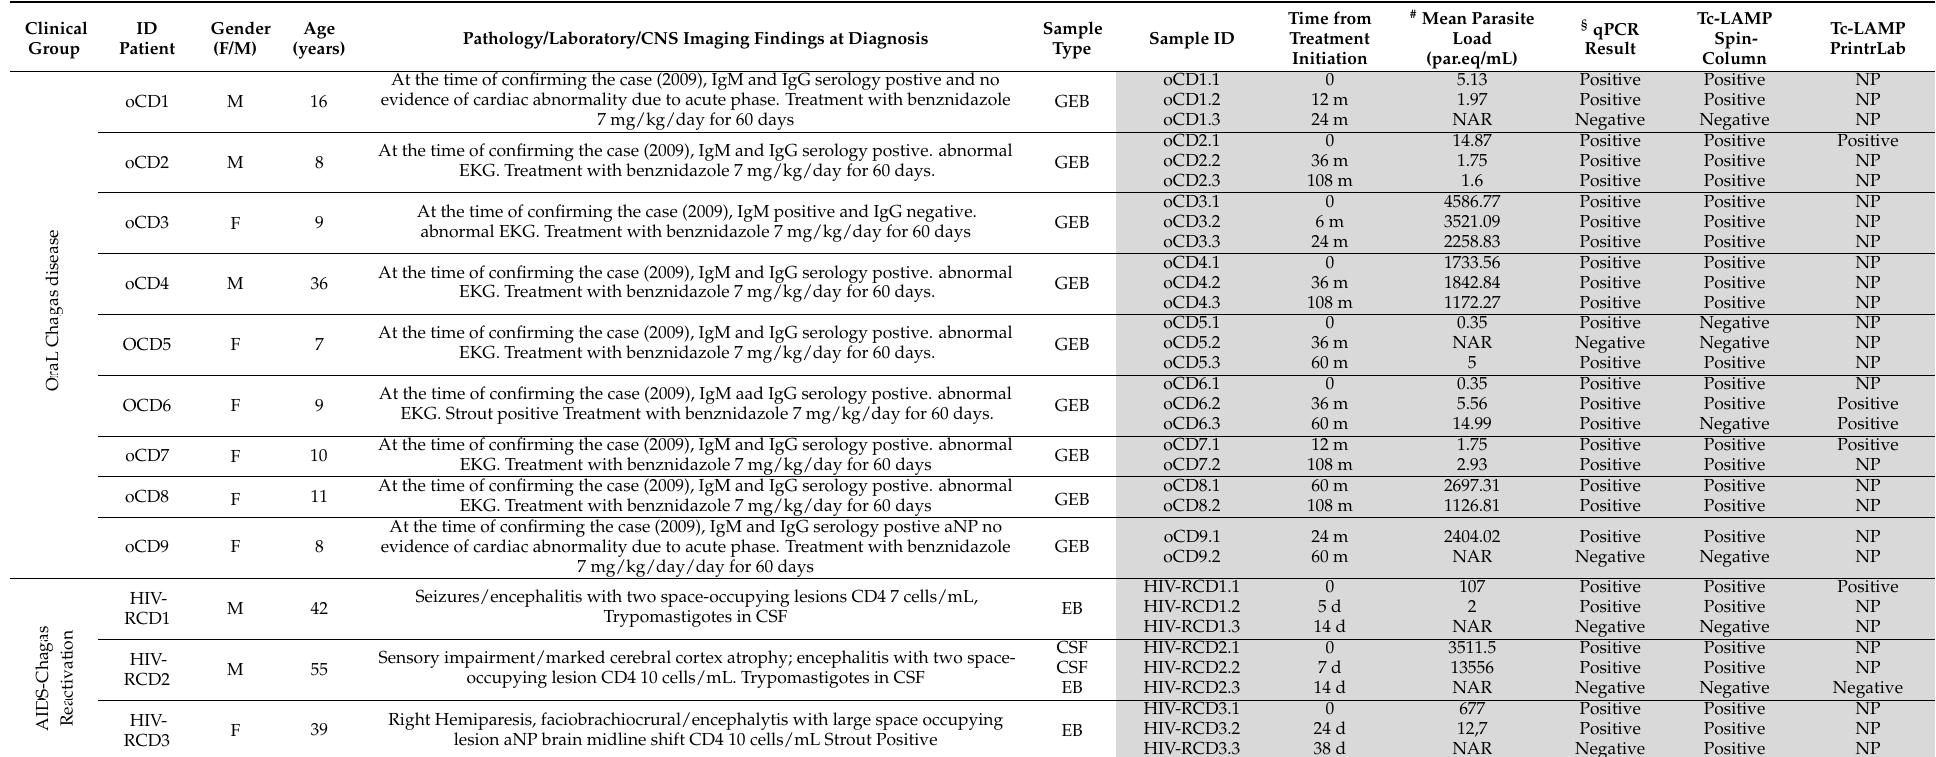
Table 1. Follow-up of oCD and HIV-RCD clinical groups by qPCR and